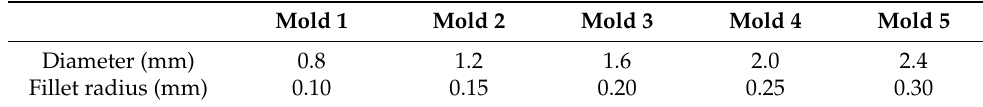
Table 3. Feature sizes of five micro